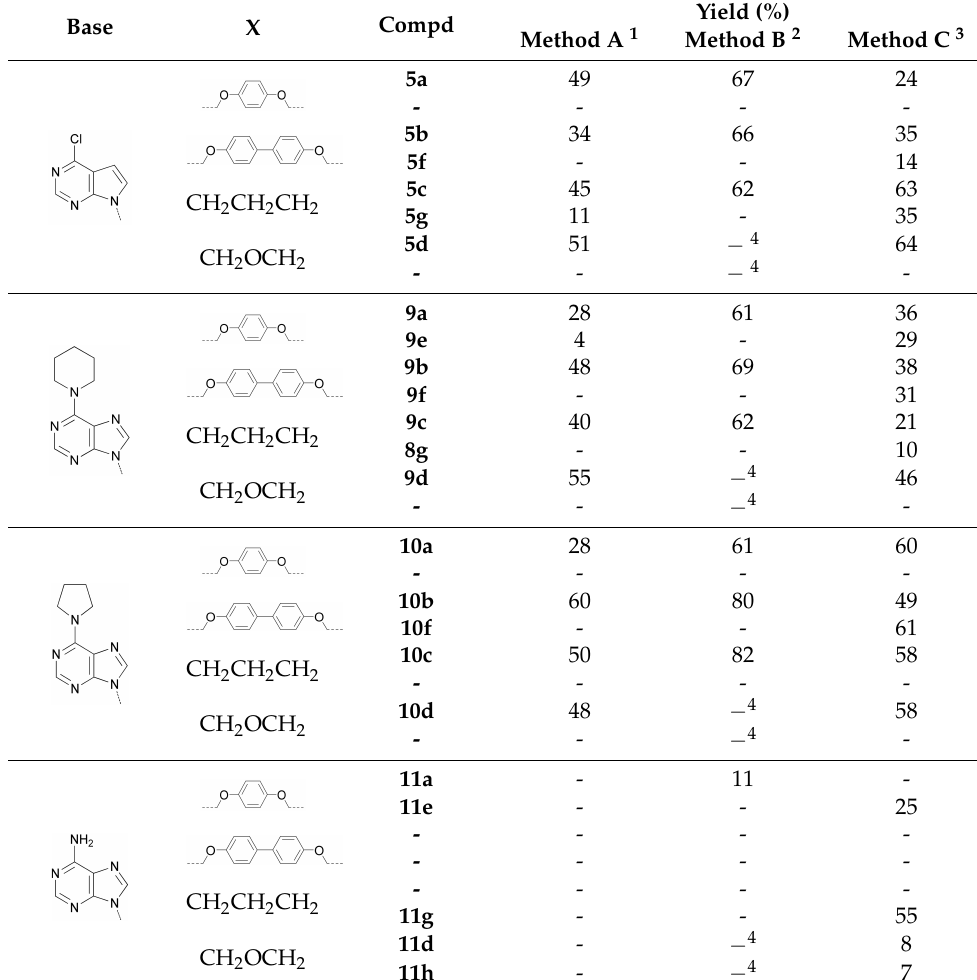
Table 1. The scope of CuAAC reactions for the synthesis of pyrrolo[2,3- d ]pyrimidines and purines using methods